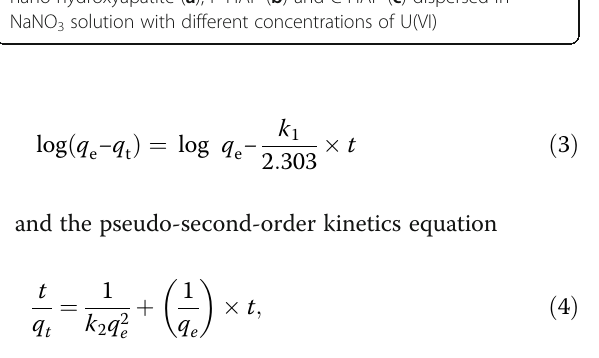
Concentration of uranyl nitrate ions in the P-HAP/NaNO3 system.